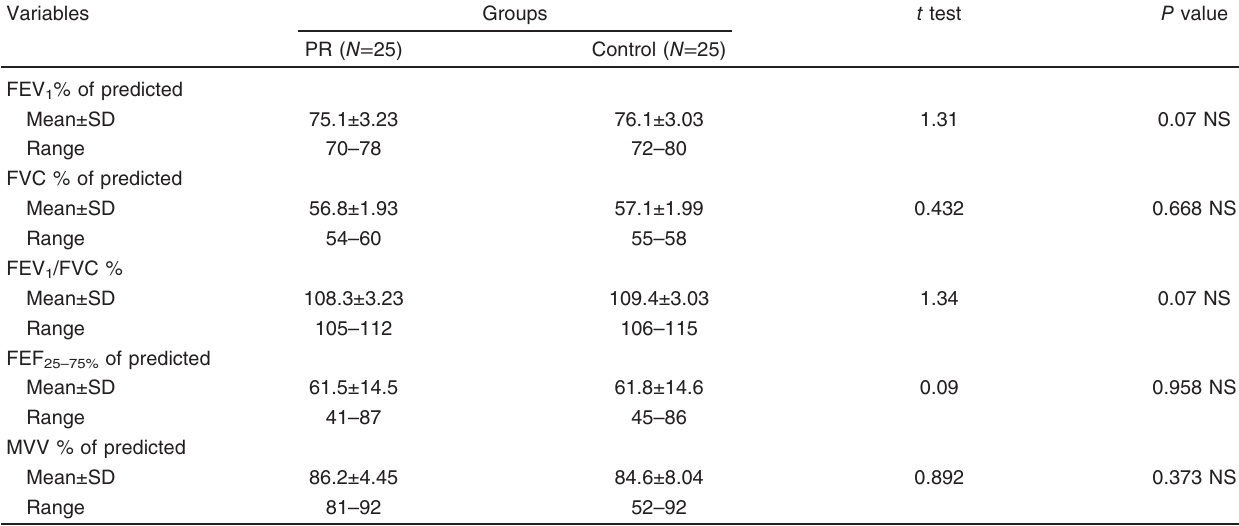
Table 2 Comparison between both groups as regards prepulmonary rehabilitation spirometric parameters